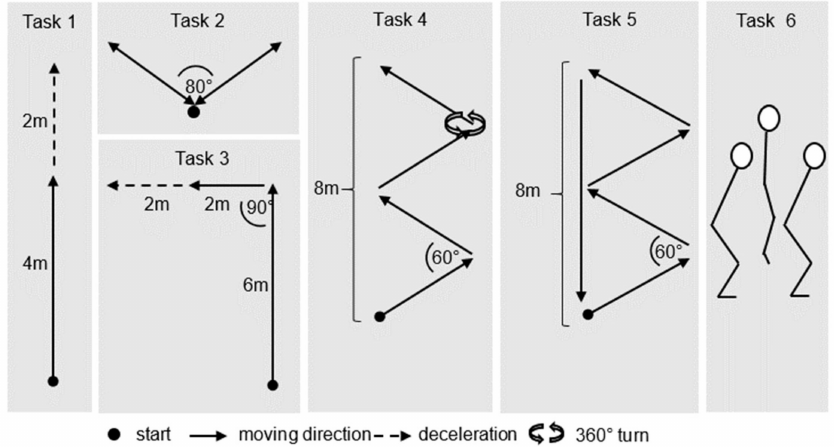
Figure 1. Graphic representation of performed movement tasks. Each task was performed at three intensities (low–moderate–high) both with and without ball possession. Adapted from Luteberget et al. [20], Task 1 consisted of a straight-line acceleration immediately followed by a deceleration to a stop. Task 2 consisted of two diagonal forward / backward movements. Task 3 was a straight-line acceleration followed by a 90 ◦ turn and deceleration to a stop. Task 4 was a zig-zag course including a 360 ◦ turn. The course was executed with forward movements and change of direction cuttings. For Task 5, five continuous laps of the same zig-zag course were executed without the 360 ◦ turn. Task 6 was added to expand the test battery through a single counter-movement jump to include motion in the vertical